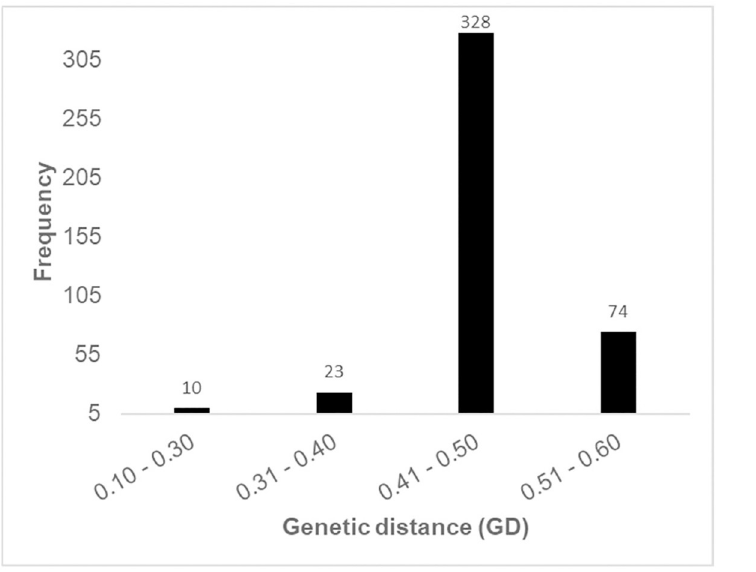
Fig 3. Genetic distance data summary of 30 parental maize lines using 92